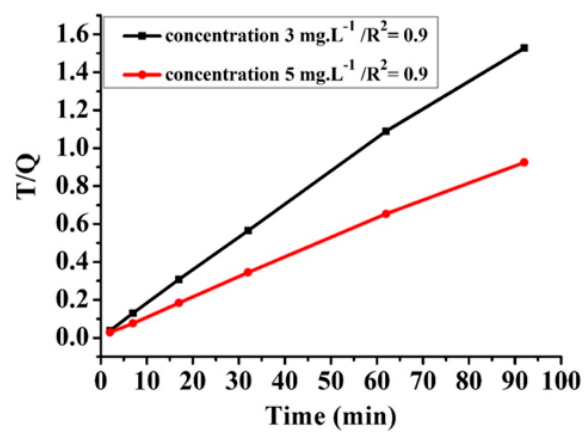
Figure 10. Plot of pseudo-second-order kinetic model for Al 3+ adsorption.